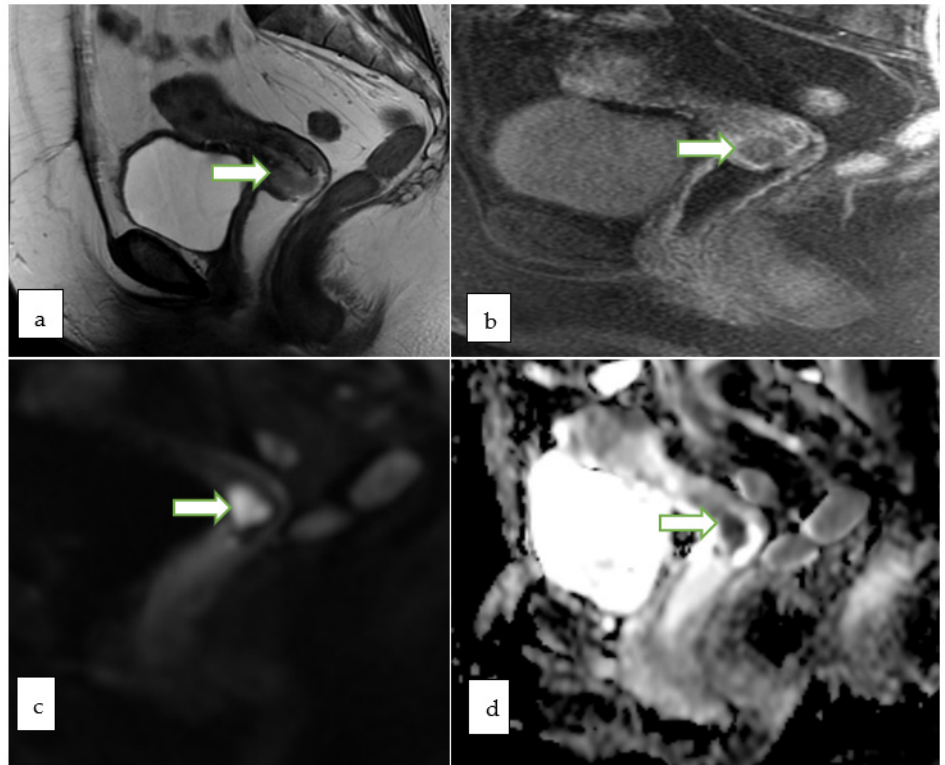
Figure 7. 53 years old patient, MRI sagittal T2 ( a ) and sagittal T1 post contrast ( b ) showing a 2.3 × 1.6 cm endophytic mass is noted within the cervix about 1.5 cm from the internal os partially infiltrating the anterior cervical lip. The lesion appears bright in DWI ( c ) and low ADC ( d ) value denoting diffusion restriction. No evidence of parametrial, pelvic side wall or nodal involvement (Revised FIGO staging stage 1B1). Histopathology of the mass revealed moderately differentiated endocervical adenocarcinoma.